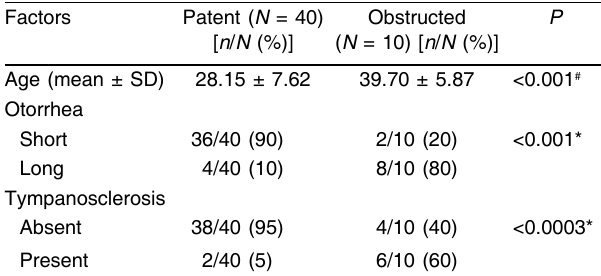
Table 1 Factors affecting the patency of